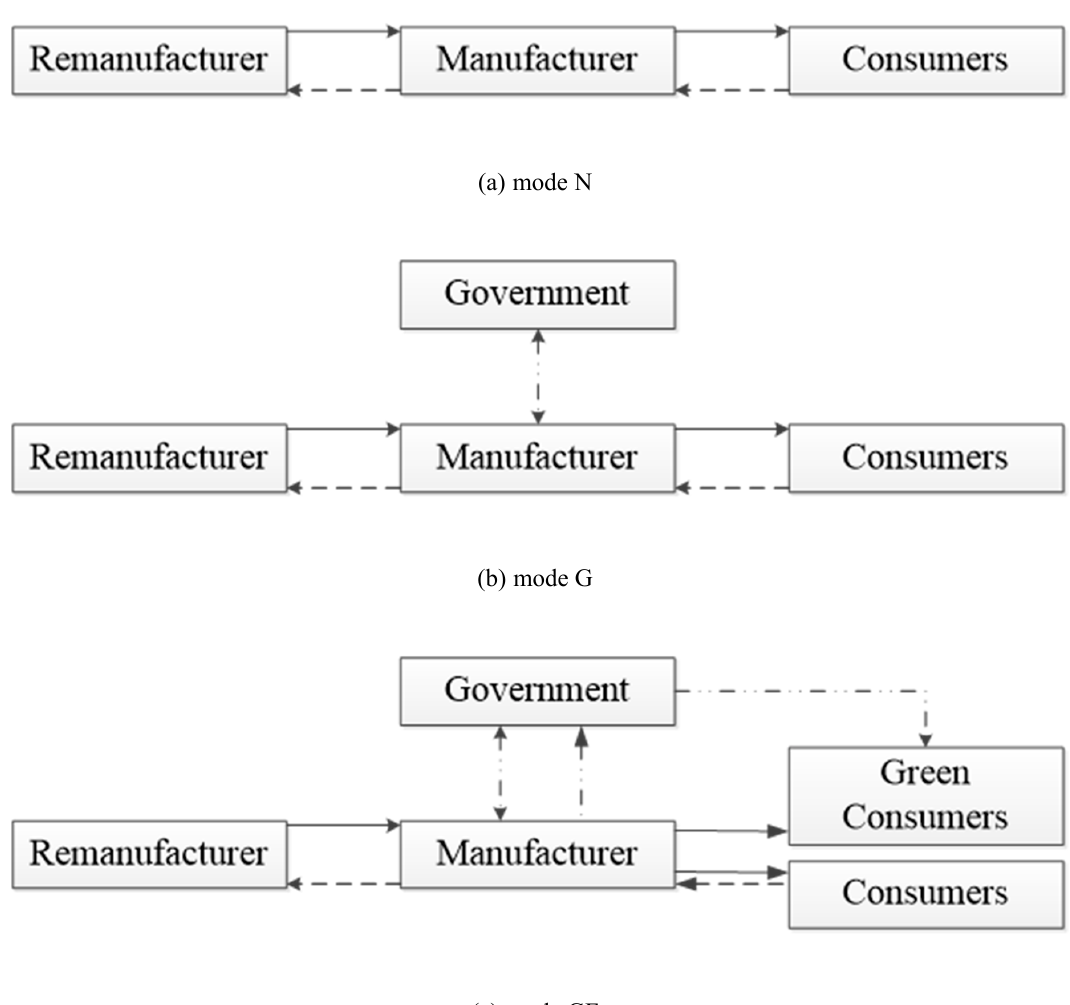
Figure 1. Three Stackelberg game models involving remanufacturing. ( a ) mode N; ( b ) mode G; ( c ) mode GF.